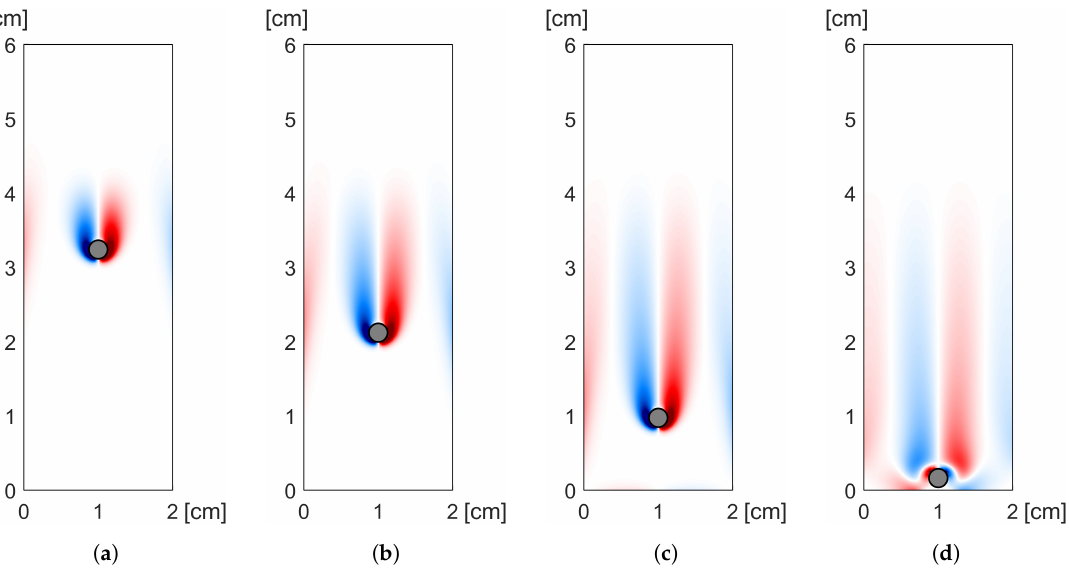
Figure 2. Flow field featured by vorticity contours at time ( a ) t = 0.2 s, ( b ) t = 0.4 s, ( c ) t = 0.6 s, and ( d ) t = 0.8 s.